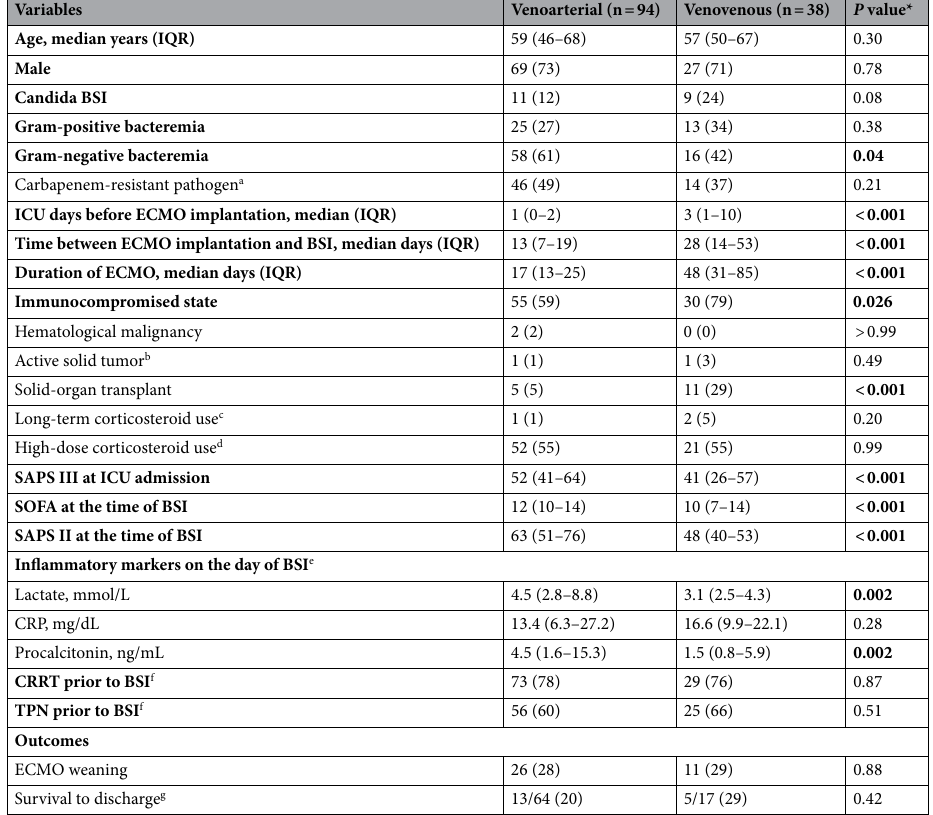
Table 2. Clinical characteristics and outcomes of the 132 bloodstream infections during venoarterial (VA) and venovenous (VV) extracorporeal membrane oxygenation (ECMO). BSI, bloodstream infection; CRP, C-reactive protein; CRRT, continuous renal replacement therapy; ICU, intensive care unit; IQR, interquartile range; SAPS, Simplified Acute Physiology Score; SOFA, sequential organ failure assessment; TPN, total parenteral nutrition. *P values with significant difference are indicated in bold. Data are presented as No. (%) unless indicated otherwise. a Resistant to at least one of the carbapenem antibiotics (ertapenem, meropenem, or imipenem). b Antitumor treatment within the previous year. c > 7.5 mg of prednisolone or equivalent